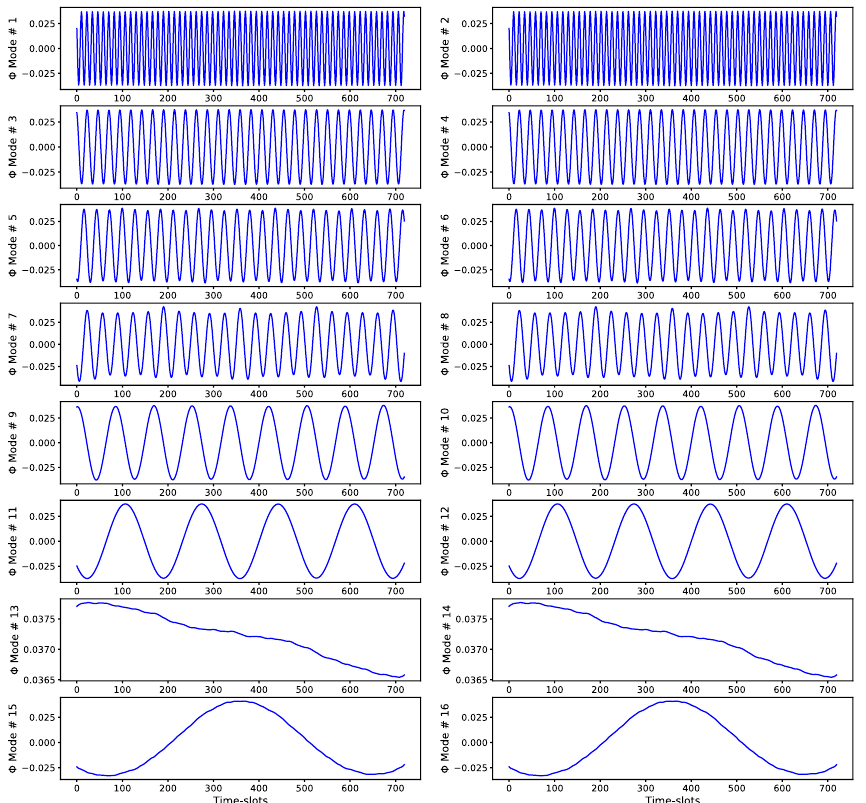
Figure 17. Principal eigenvectors ( Φ ) of the DMD algorithm (best linear mapping) for the temporal evolution of the load values. The eigenvectors are in order of importance (according to their corre- sponding eigenvalues) and represent the main modes of temporal evolution of the time-series. They clearly show the strong daily/weekly periodicity of the load values. The values shown correspond to a rolling window of 720 h (1 month). In this case, 16 eigenvectors were needed to capture 99% of the total signal energy.